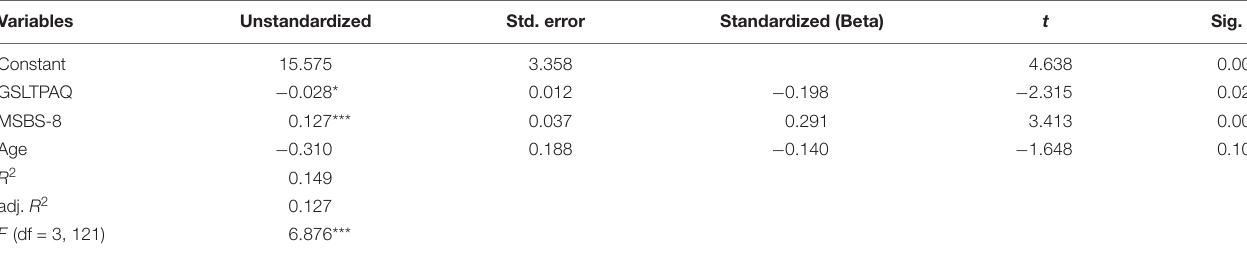
TABLE 2 | Coefficients and R 2 for the regression model; dependent variable fear of